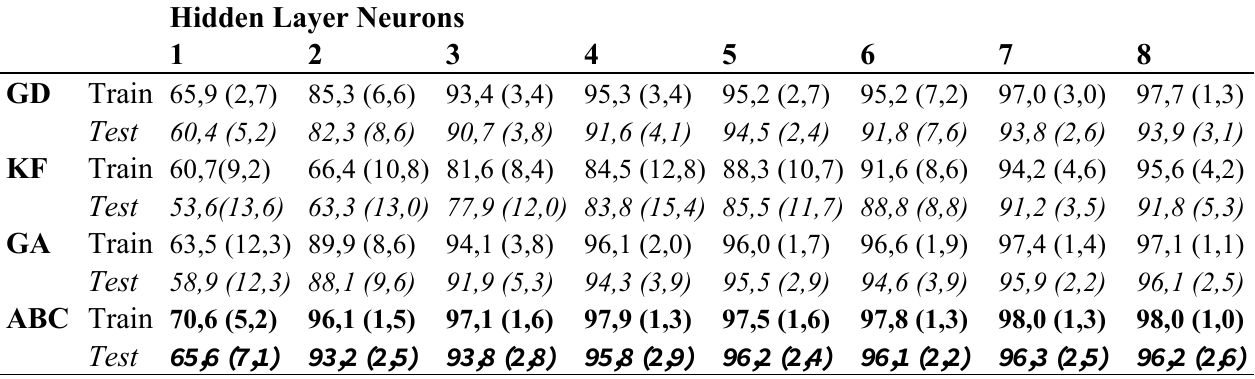
Table 4. Statistical PCCS results of Iris